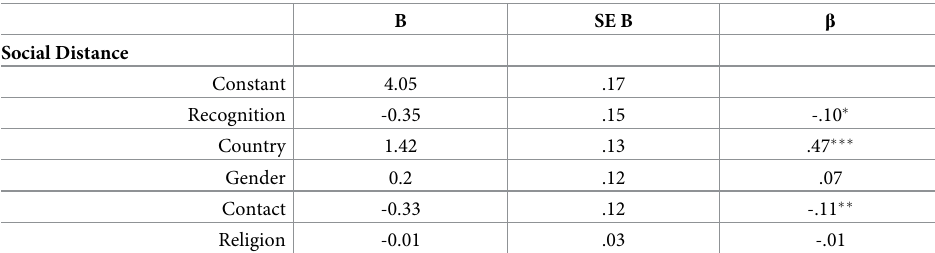
Table 6. Predictors of social distance: Results of multiple regression analyses.